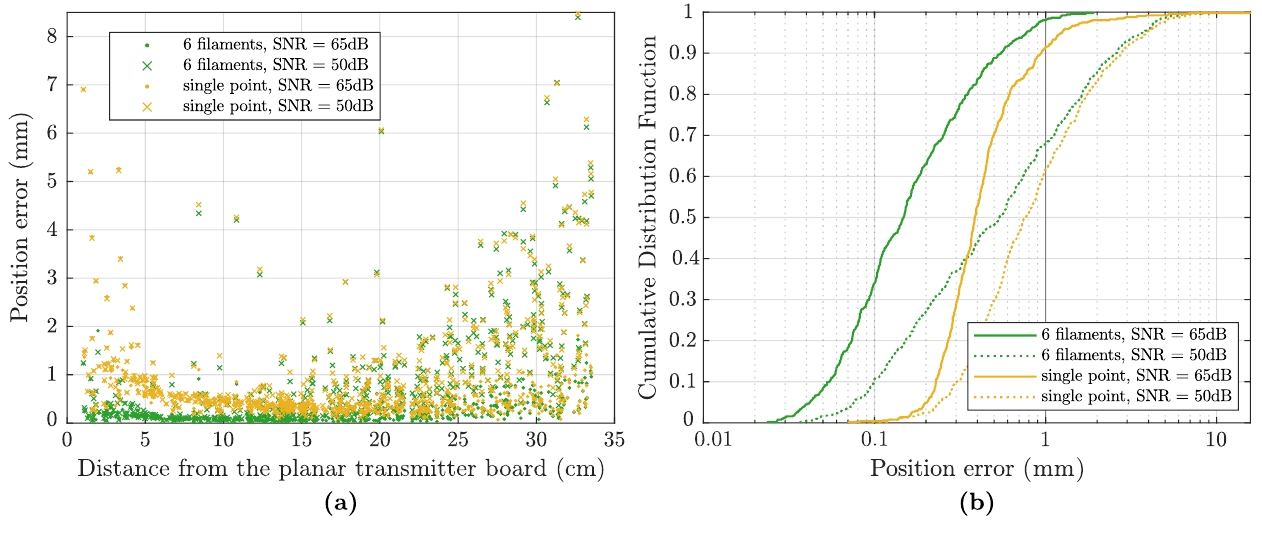
Figure 14. ( a ) Static accuracy test simulation with noisy data, two noise levels are compared. Position errors depend on model approximations and on noise magnitude. ( b ) Cumulative distribution function of the position error, for the two magnetic models considered and average noise levels of 50 and